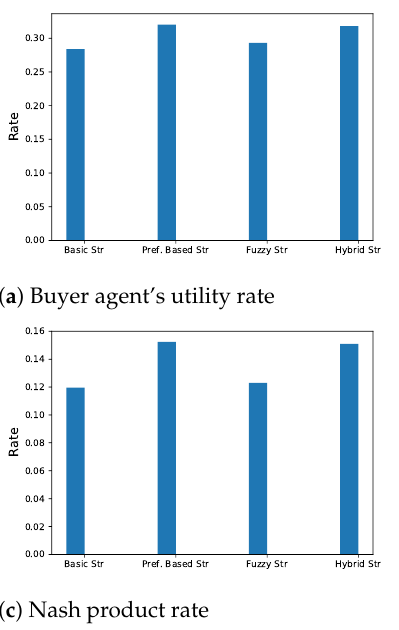
Figure 12. Utility and Nash product rates per agreement with large overlap and random